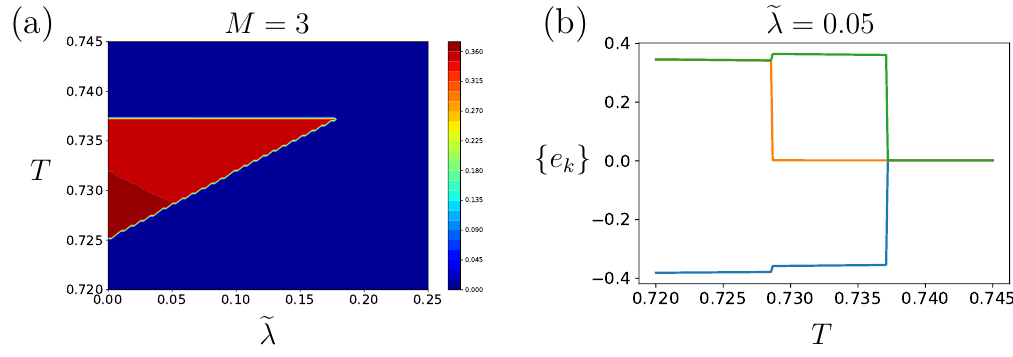
g 1 = 1 and g 2 = 5 in the large- N e e